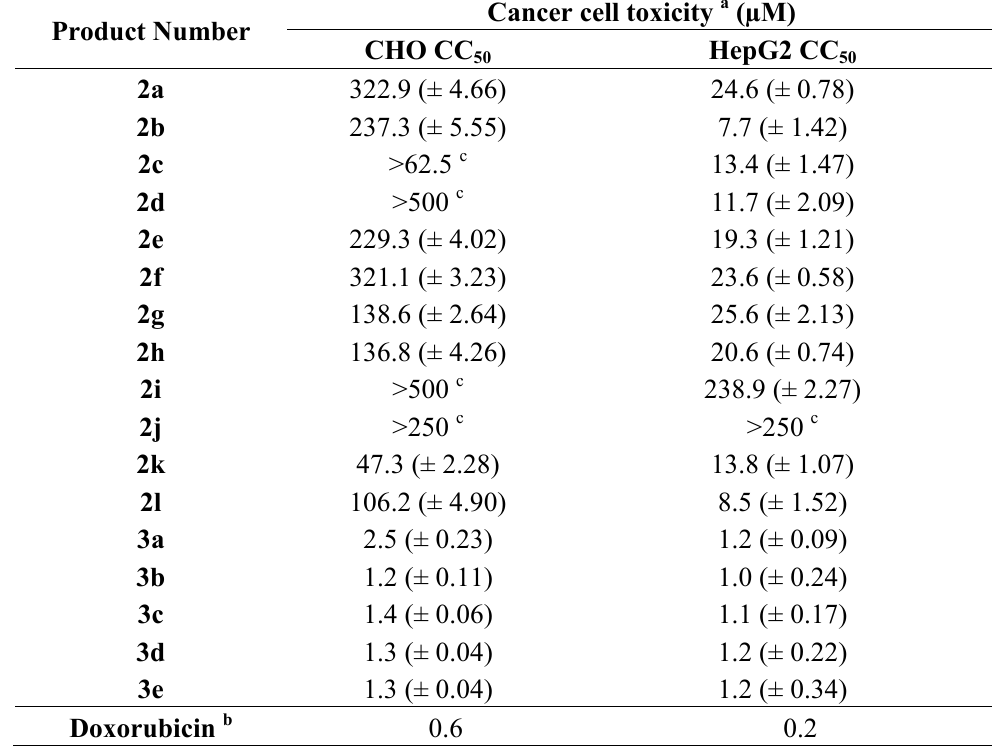
Table 4. Antiproliferative activity of compounds 2a to 3e